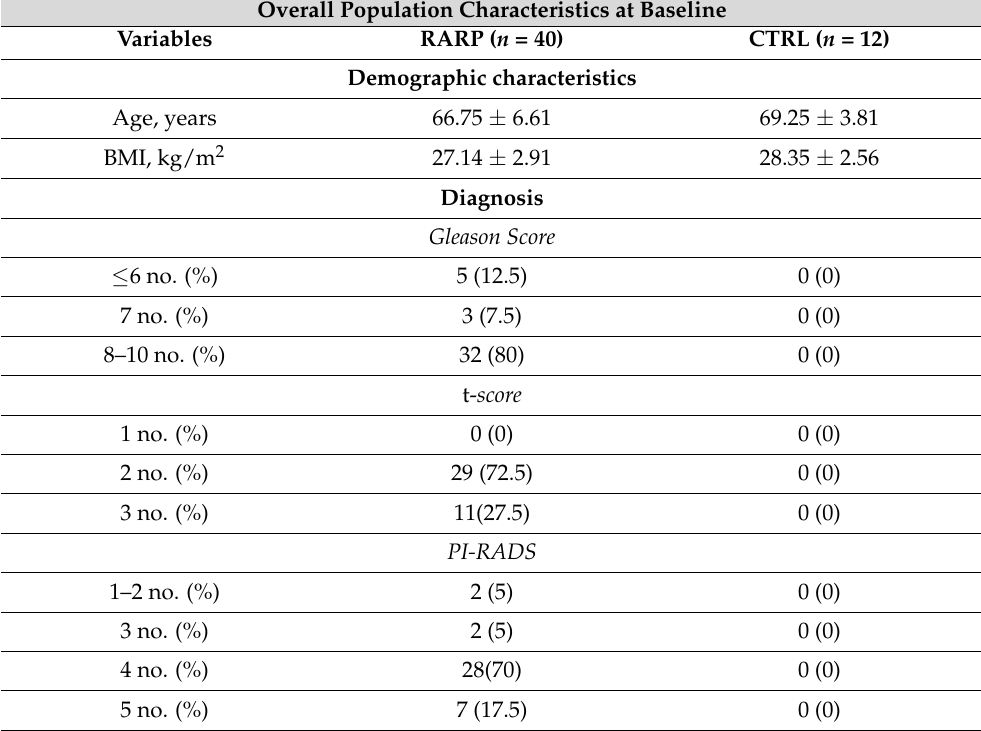
Table 1. Characteristics of the RARP patients and control